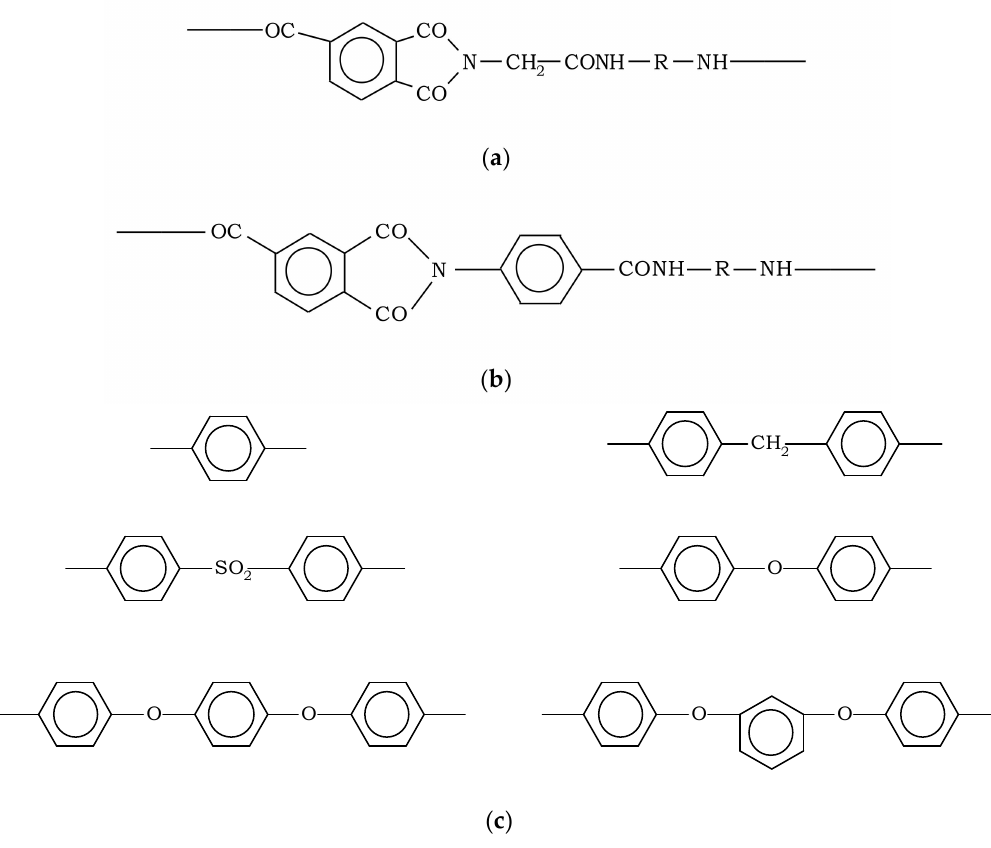
Figure 1. Chemical structure of monomer units of polyamidoimides: ( a ) PAI-A, ( b ) PAI-B, and ( c ) R — Figure 1. aromatic radical of the diamine fragment. and ( c ) R—aromatic radical of the diamine